Question: What form of chart is displayed?
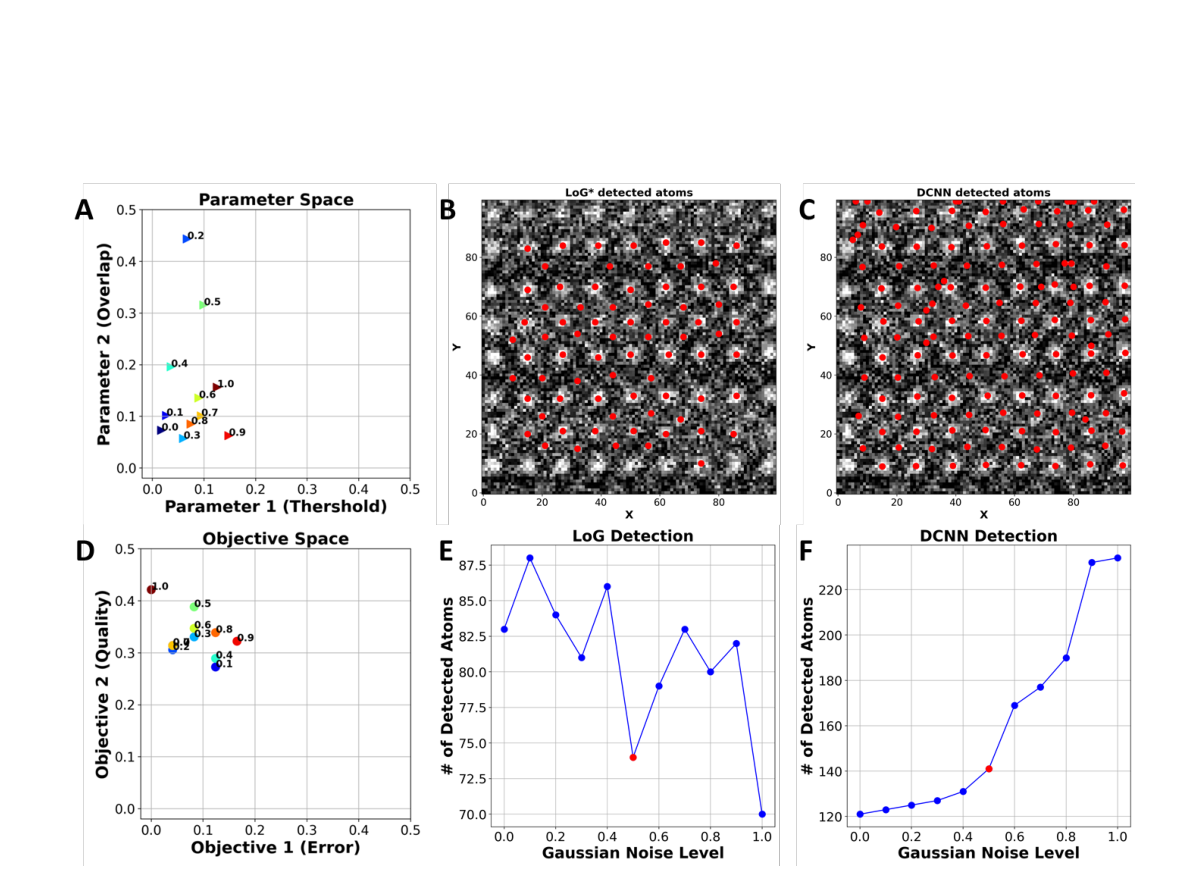
Answer: scatter